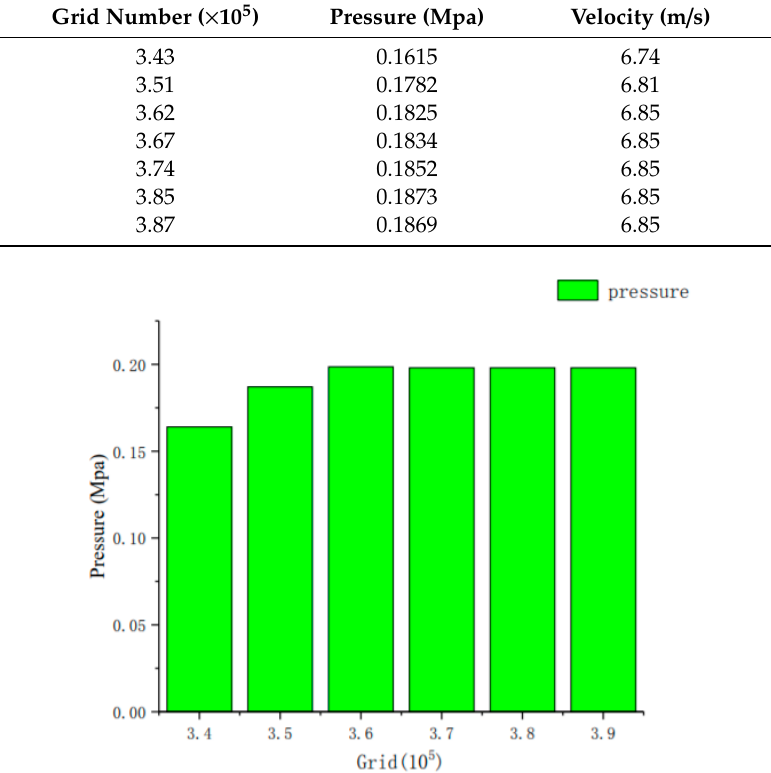
Figure 10. Mesh Figure 10. Mesh independence.